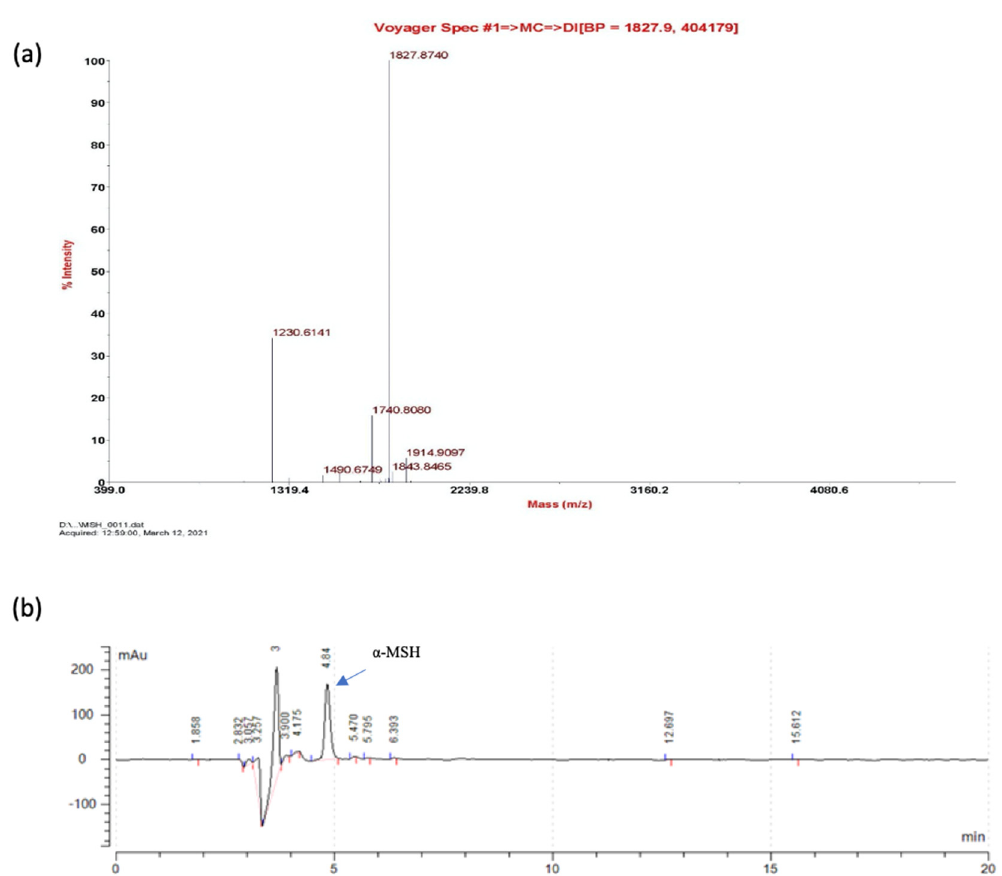
Figure 5. Identification of the pepsin-cleaved α -MSH. ( a ) MALDI-TOF analysis demonstrates the identity of α -MSH with the expected molecular weight (1827.87); ( b ) HPLC analysis of pepsin-cleaved α -MSH peptide. The arrow indicates the peak corresponding to the chemically synthesized α -MSH standard.